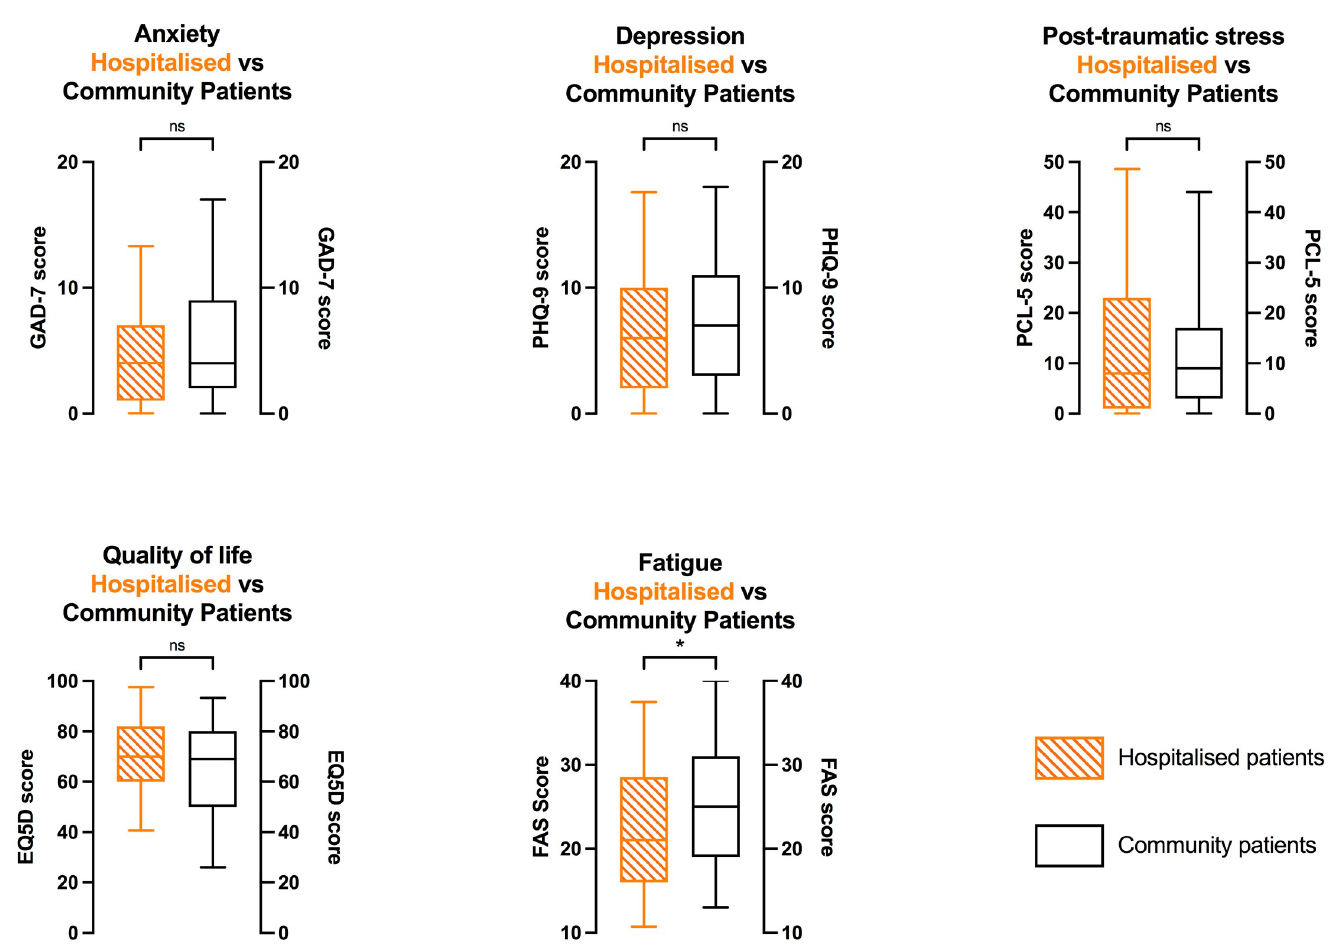
Fig 2. Comparison of patient reported outcome measures (PROMS) between severe acute COVID-19 illness (defined by requiring hospitalisation) and COVID-19 treated in the community. GAD-7: Generalised anxiety disorder-7 [0–21]; PHQ-9: Depression module of the patient health questionnaire [0–27]; PCL-5: Posttraumatic stress disorder checklist for DSM-5 (diagnostic and statistical manual of mental disorders) [0–80]; EQ5-D: EuroQoL 5-dimension quality of life instrument [0–100]; FAS: Fatigue assessment scale